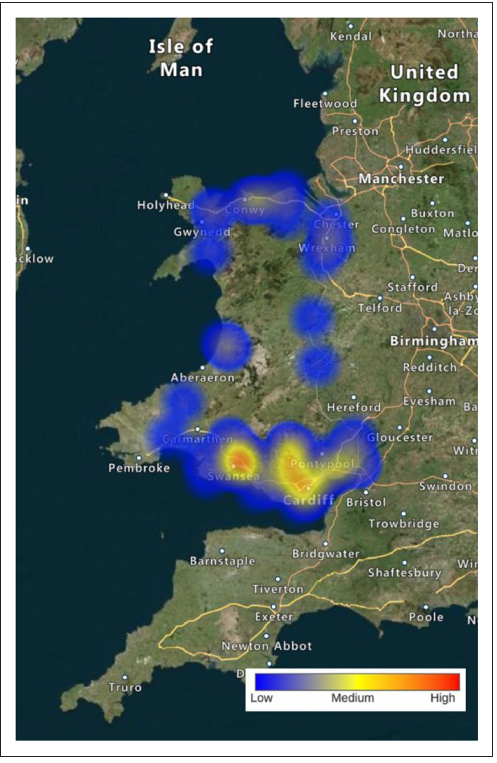
Figure 1 Heat map demonstrating geographical distribution of